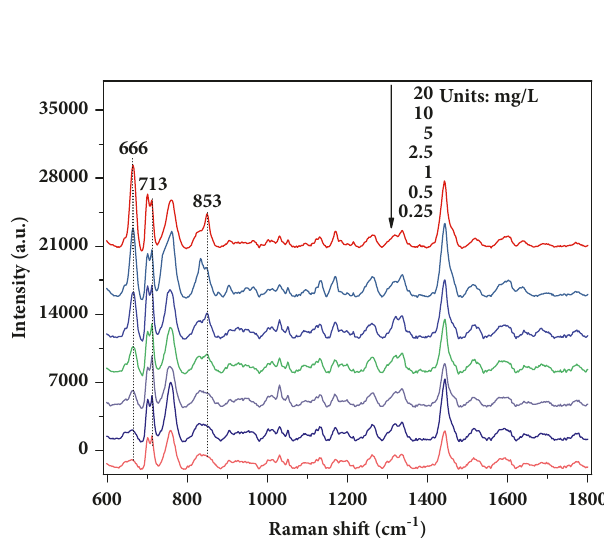
Figure 4: Spectra of 20, 10, 5, 2.5, 1, 0.5, or 0.25 mg/L of chlormequat chloride in wheat extraction